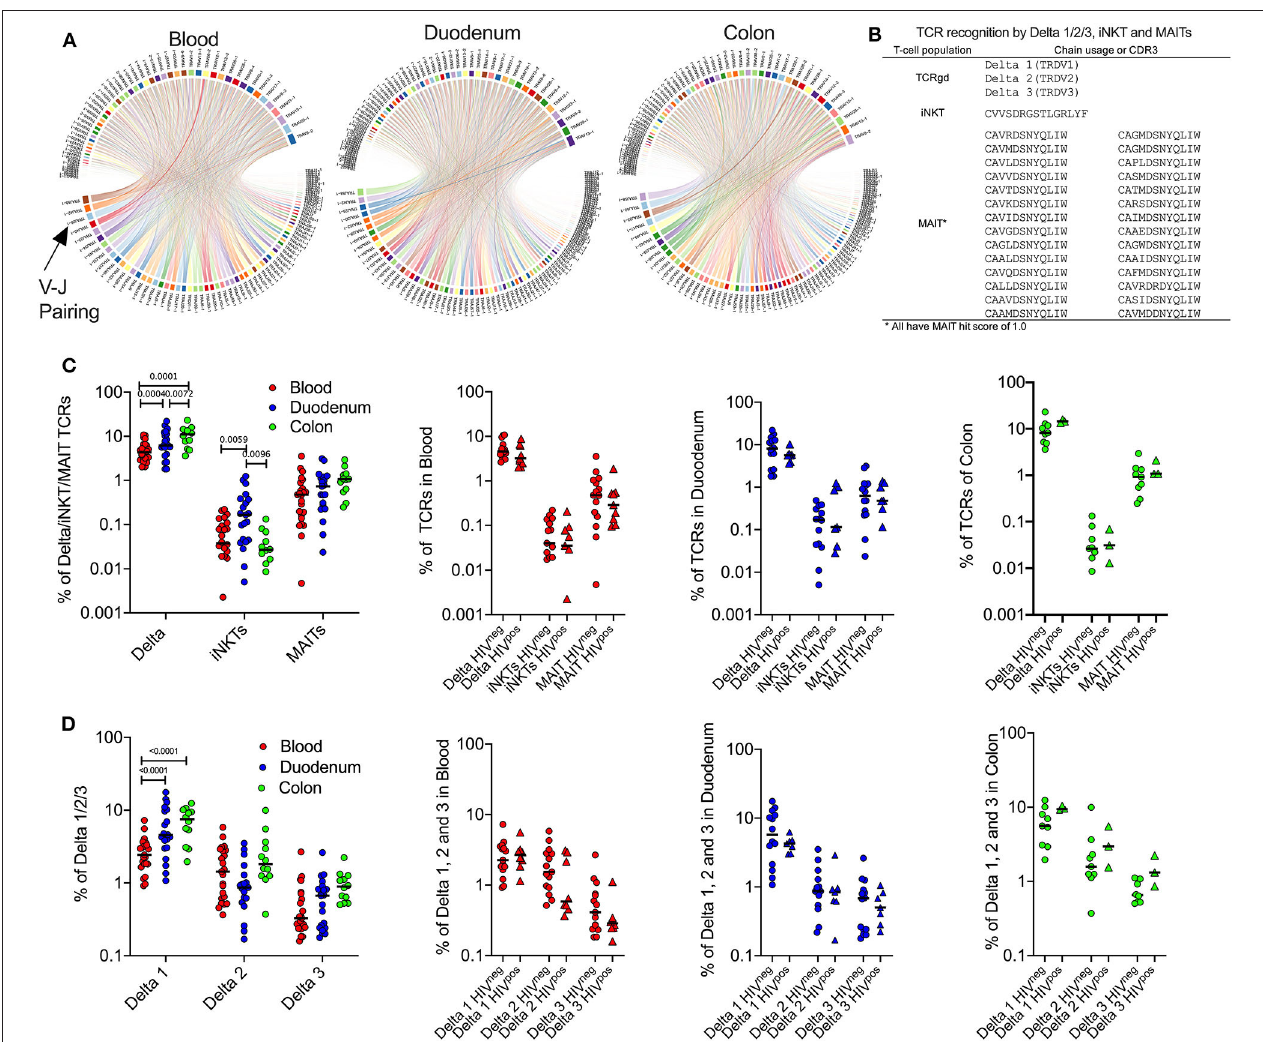
FIGURE 4 | Compartment-specific expansion of γδ T-cells in colon and iNKT cells in duodenum GALT tissue. (A) TRAV-TRAJ segment usage wheels are shown for 1 representative sample of blood, duodenum and colon (PID 022-09-1069, 022-09-2078, and 022-09-1070, respectively; Supplementary Table 1 ). The size of the arcs is proportional to V or J frequency. The ribbon joining any V-J pair is proportional to the co-occurrence frequency of that pair. Co-occurrence (“circos”) wheels were generated by VDJ tools ( 35). All 3 participants were HIV –ve. (B) Overview of TCR sequencing-based definition of unconventional T-cell subsets used in this study. (C) Left: Frequency of unconventional T-cell subsets as defined by TCR sequences displayed in (B) in blood (red; n = 24), duodenum (blue; n = 21) and colon (green; n = 12) samples. Plot includes HIV– and HIV + participants. Right panels: Same as in the left panel but comparing HIV –ve (circles) vs. HIV + ve (triangles) samples. (D) Same as in (C) but comparing frequencies of γδ T-cell subsets. Black lines represent median. Dunn’s multiple comparisons